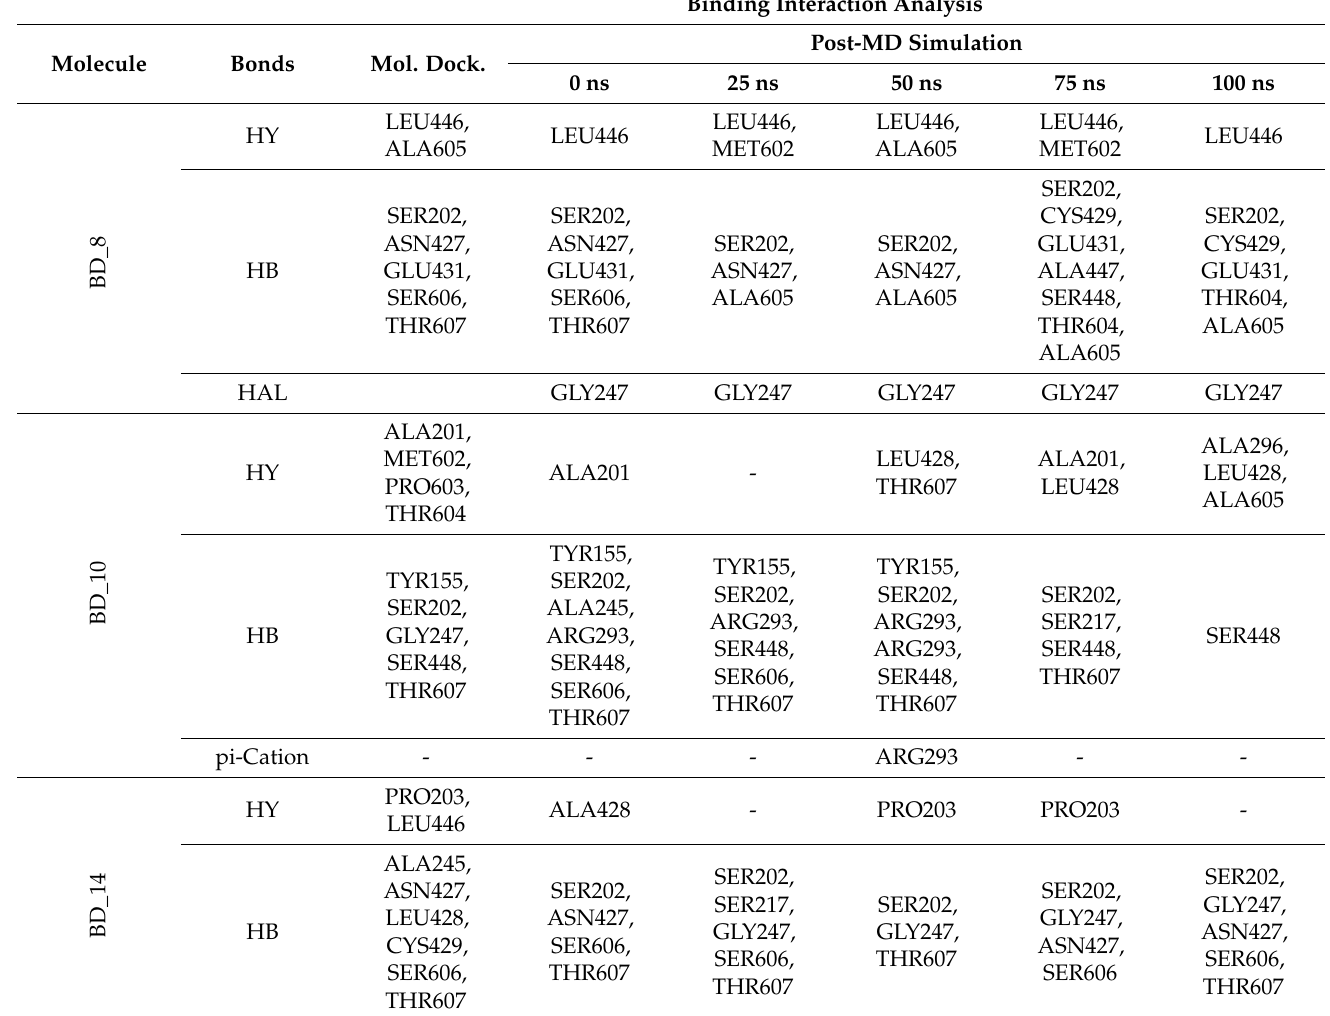
Binding Interaction